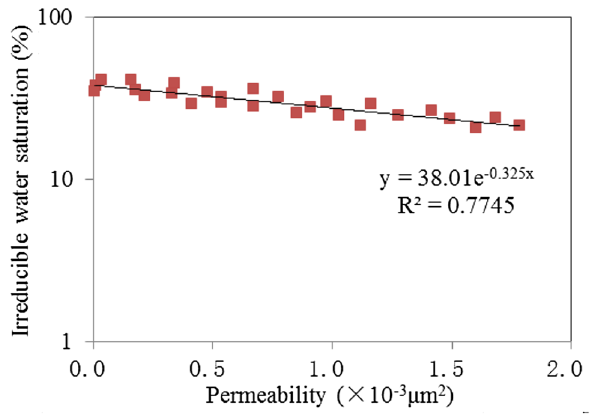
Fig. 4 Regression relation curve between irreducible water saturation and permeability